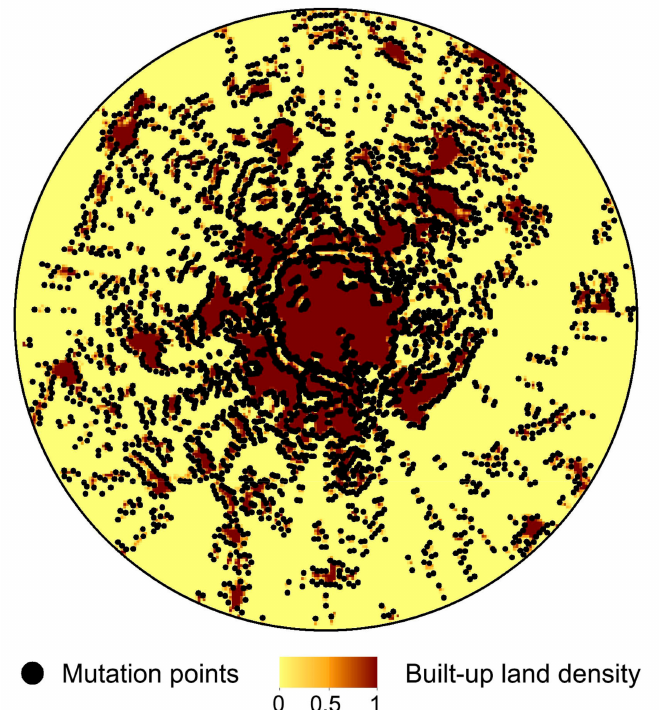
Figure 7. Extraction results for the sample. The sample area is located between longitudes 103 ◦ 15 (cid:48) E to 104 ◦ 45 (cid:48) E and latitudes 30 ◦ 00 (cid:48) N to 31 ◦ 15 (cid:48) N. It is the most developed area of Chengdu and its urbanization is evident. Furthermore, the radius of the sample area is approximately 60